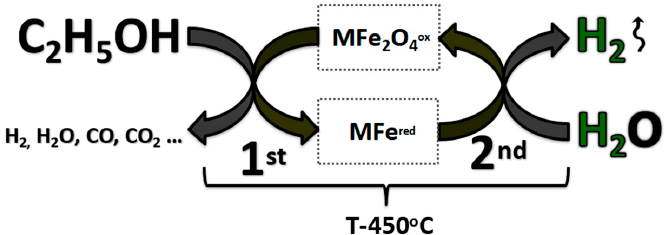
Figure 2. The chemical-loop reforming of ethanol over modified ferrospinels.